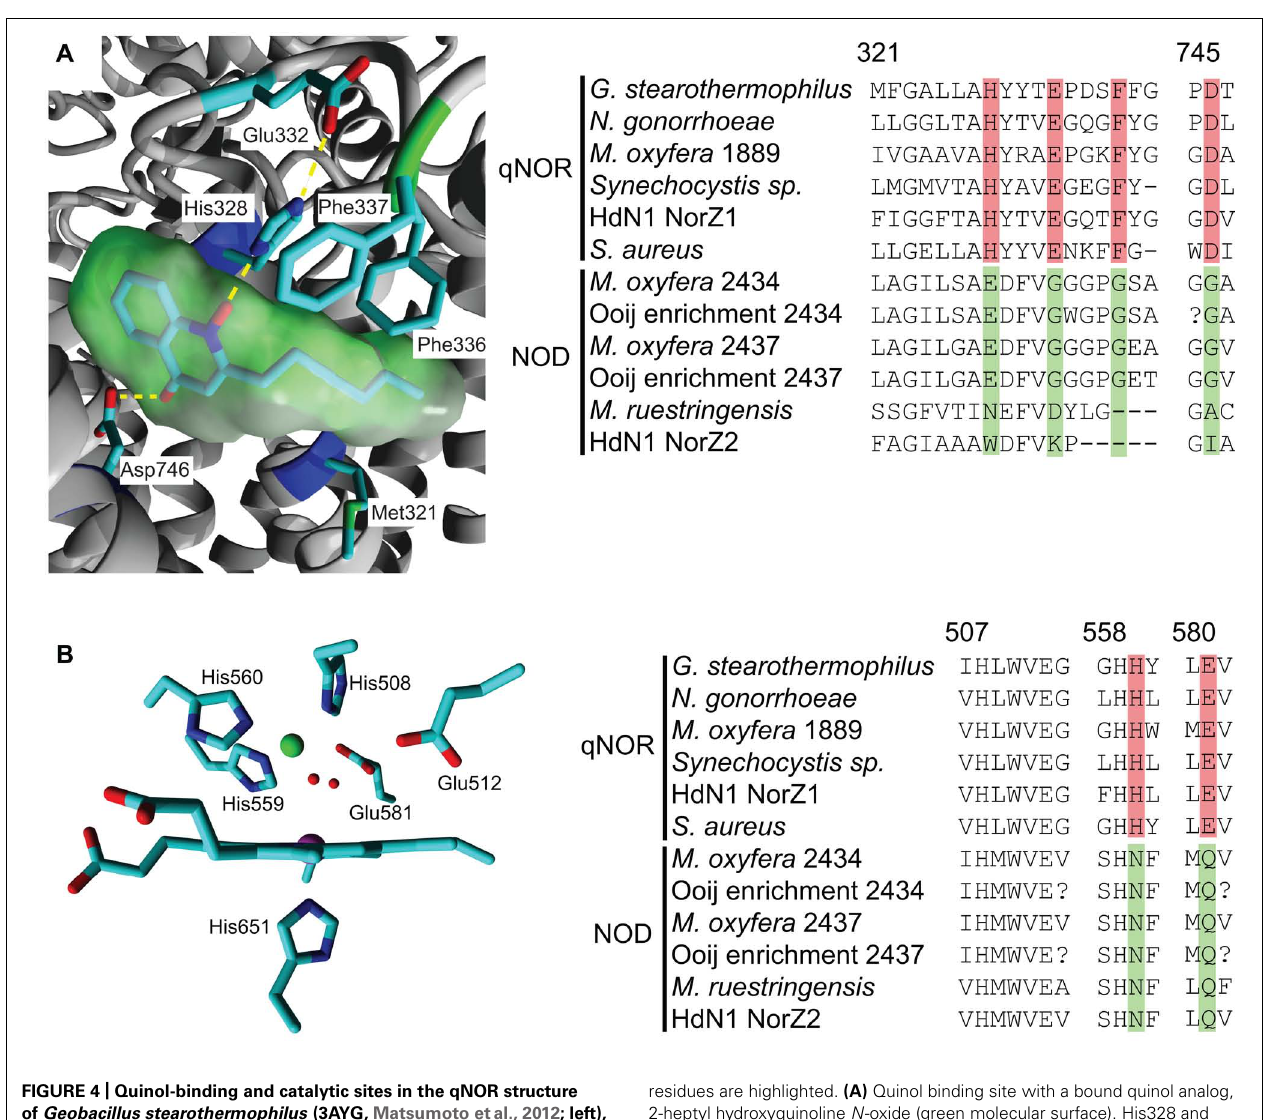
residues are highlighted. (A) Quinol binding site with a bound quinol analog, 2-heptyl hydroxyquinoline N -oxide (green molecular surface). His328 and Asp746 form hydrogen bonds with the quinol moiety and the large hydrophobic residues interact with the hydrophobic tail. (B) View of the catalytic site from the plane of the heme b 3 .The Zn B is indicated in green and two water molecules in the coordination sphere of the Zn B are indicated as small red